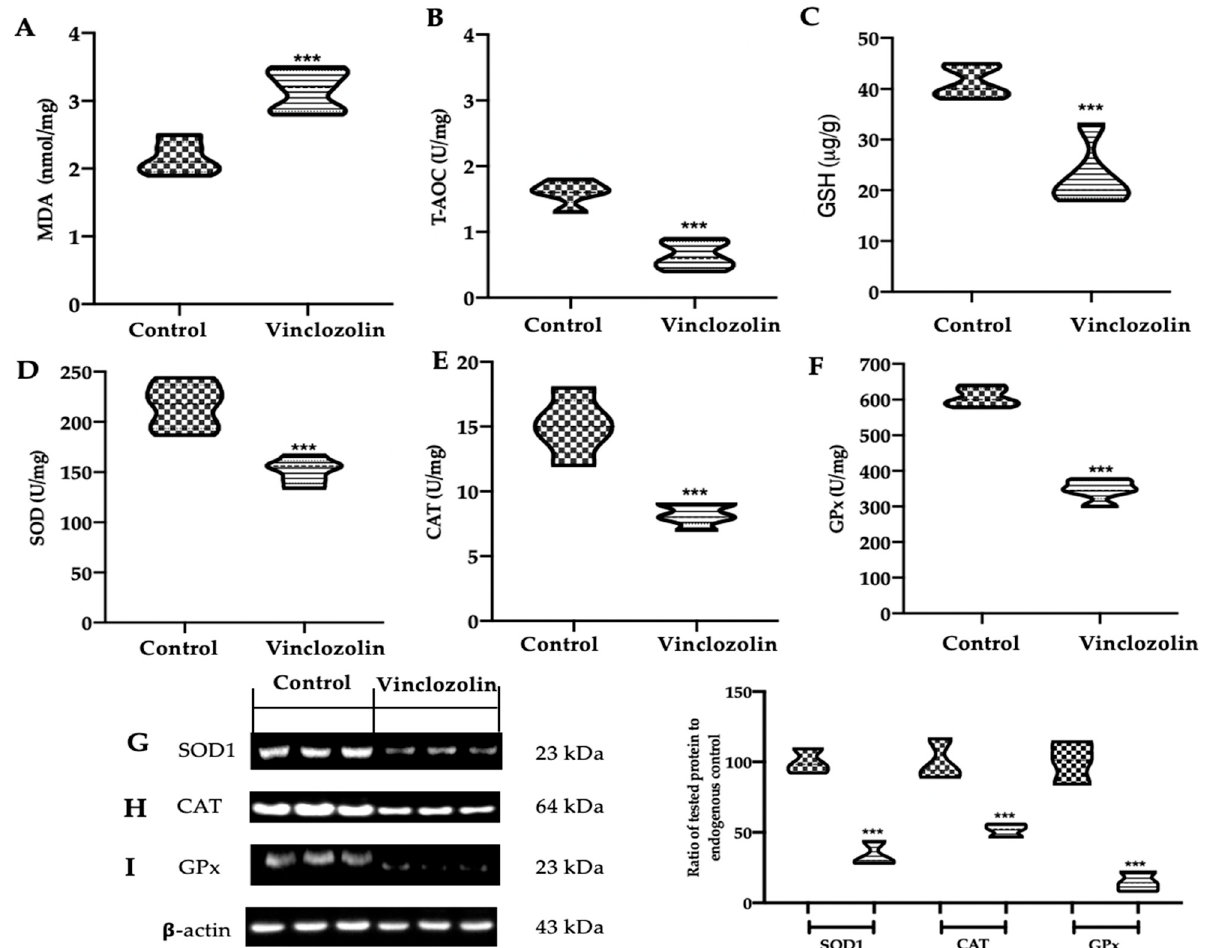
Figure 7. Effects of vinclozolin exposure on oxidative stress response: ( A ) MDA content; ( B ) T-AOC